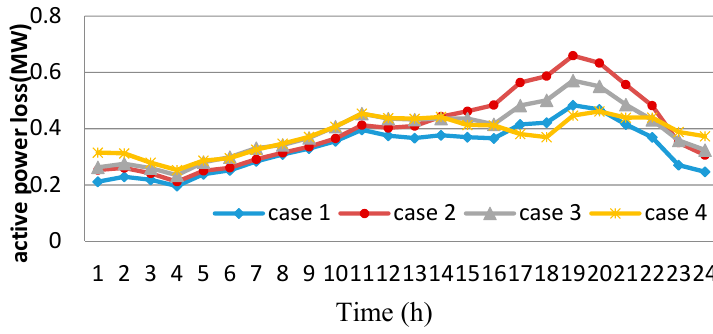
Energies 2016 , 9 , 560 Figure 6. Load curves of distribution network in different cases. Figure 6. Load curves of distribution network in different cases.